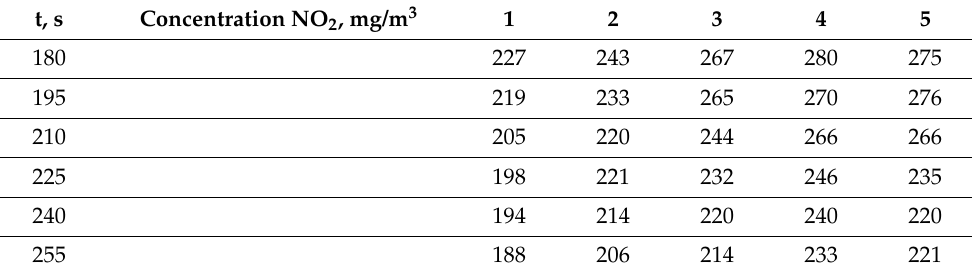
Table 2. Cont. t, s Concentration NO 2 , mg/m 3